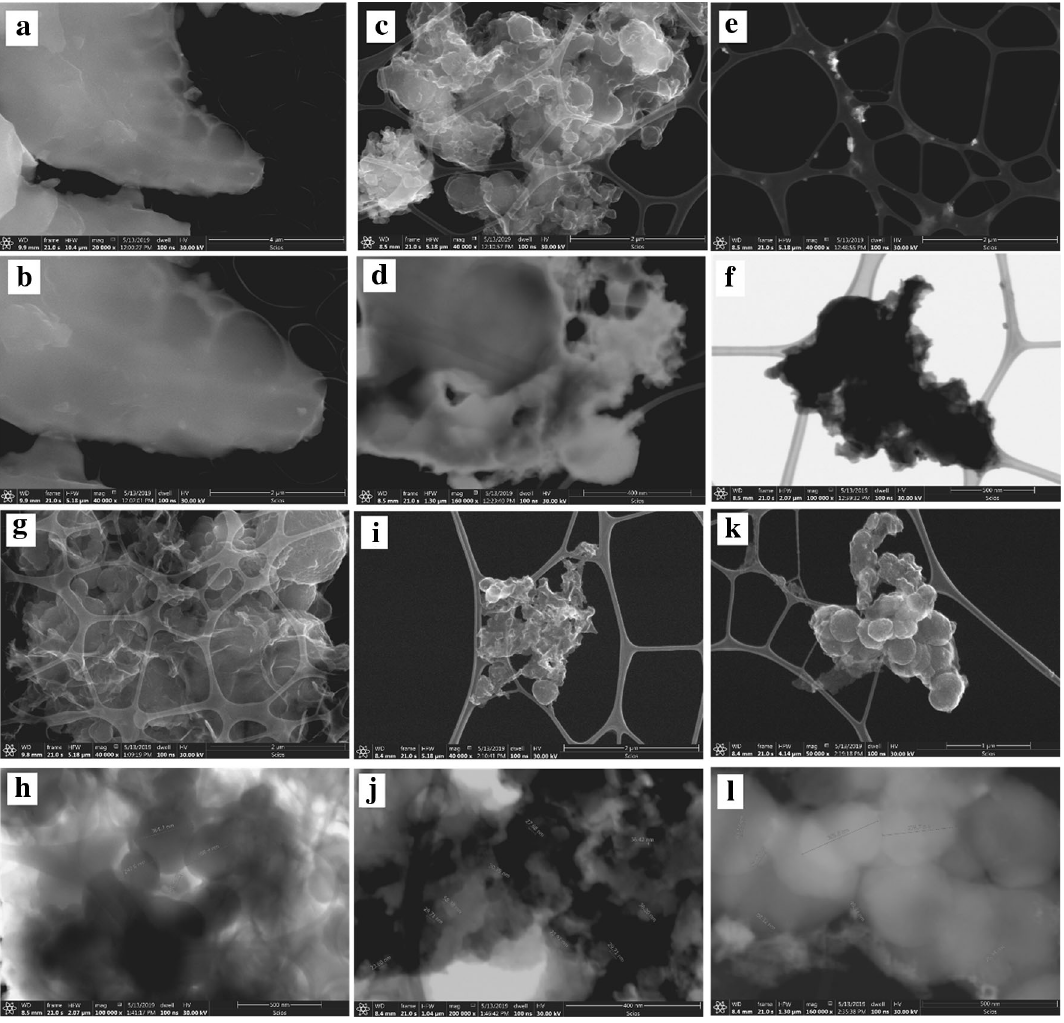
Fig. 9 a , b Initial CTP sample at a 40,000 9 in normal and STEM mode, respectively; c obtained solids at 600 (cid:3) C, 40,000 9 normal mode; d obtained solids at 600 (cid:3) C, 160,000 9 STEM mode; e obtained solids at 700 (cid:3) C, 40,000 9 normal mode; f obtained solids at 700 (cid:3) C, 100,000 9 STEM mode; g obtained solids at 800 (cid:3) C, 40,000 9 normal mode; h obtained solids at 800 (cid:3) C, 100,000 9 STEM mode; i obtained solids at 850 (cid:3) C, 40,000 9 normal mode; j obtained solids at 850 (cid:3) C, 200,000 9 STEM mode; k obtained solids at 900 (cid:3) C, 40,000 9 normal